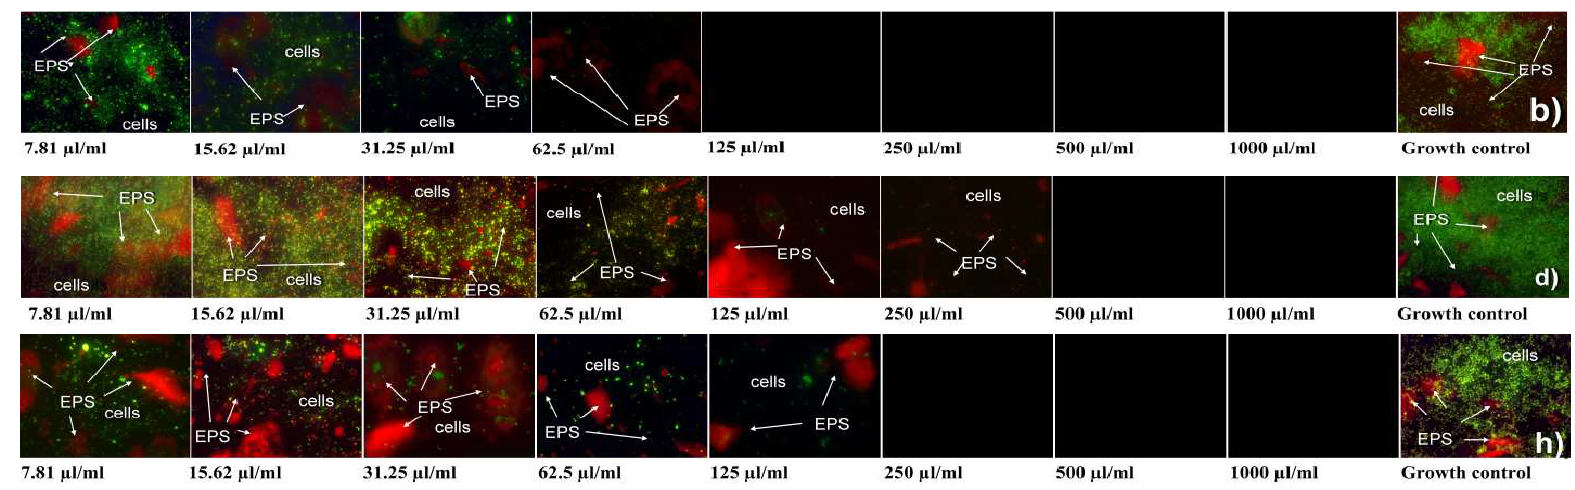
Figure 4. Influence of the test substance 4 on biofilms b) b) E. coli PMFKG-F2, d) P . mirabilis PMFKG-F4, h) S. cerevisiae PMFKG-F6. EPS – Extracellular polymer